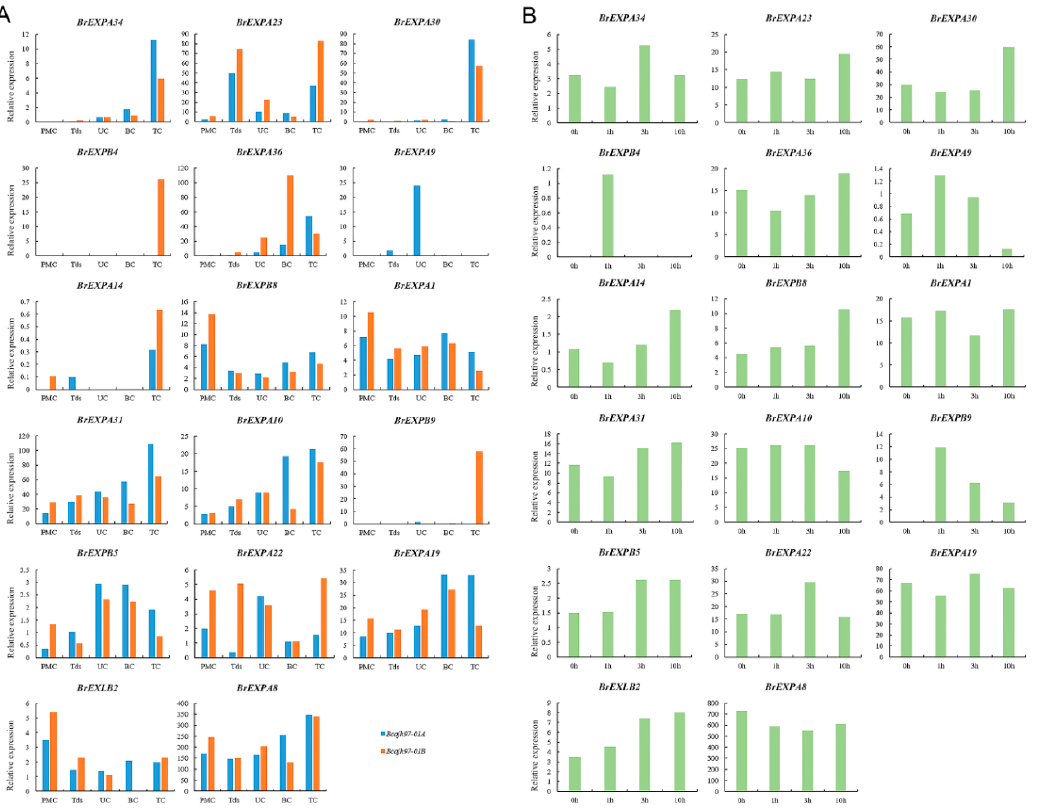
Figure 11. Expression profile analyses of representative expansin genes by RNA-Seq data in five development stages of pollen in ‘ Bcajh97-01A / B ’ ( A ) and pollinated pistils at 0, 1, 3, and 10 h after pollination ( B ). PMC pollen mother cell, Tds tetrads, UC uninuclear pollen, BC binucleate pollen, TC trinucleate pollen.